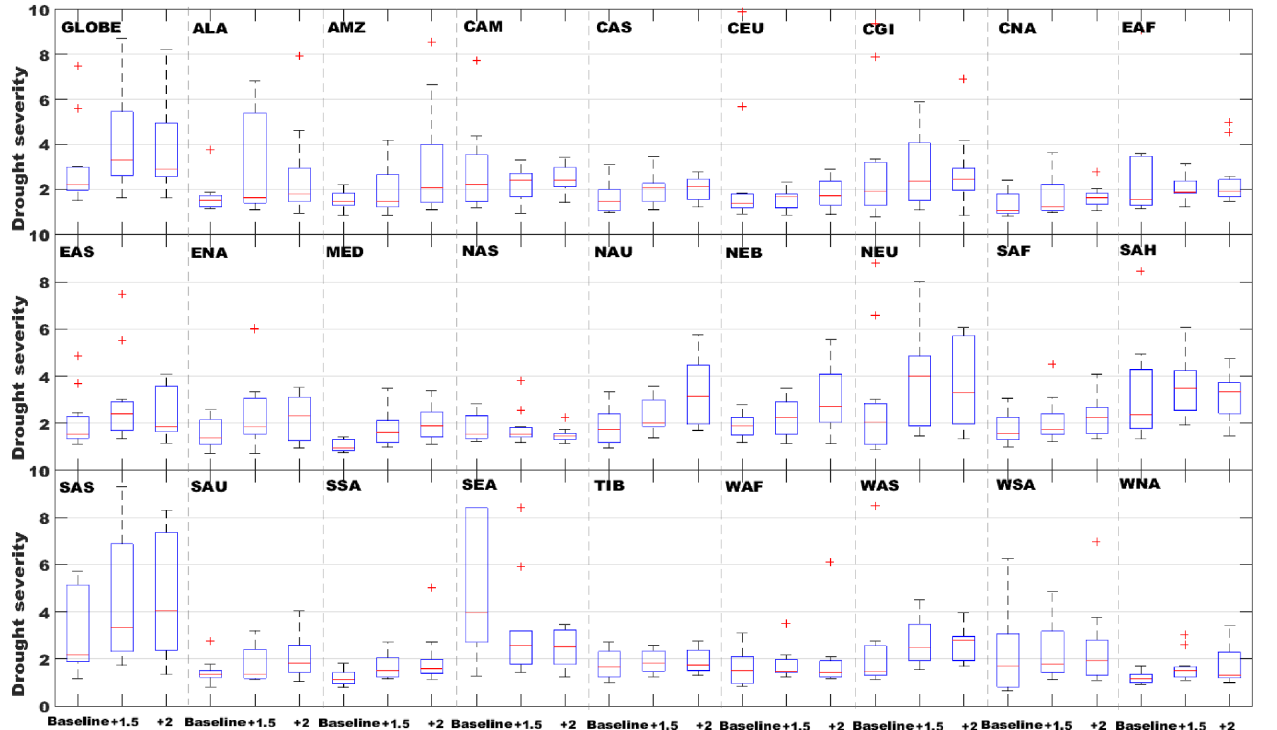
Figure 10. Multi-model projected drought severity (dimensionless) globally (66 ◦ N–66 ◦ S) and in 27 world regions for the baseline period and the 1.5 and 2 ◦ C warmer worlds. The projected uncertainty of multiple climate models is shown through box plots for each region and for each period.